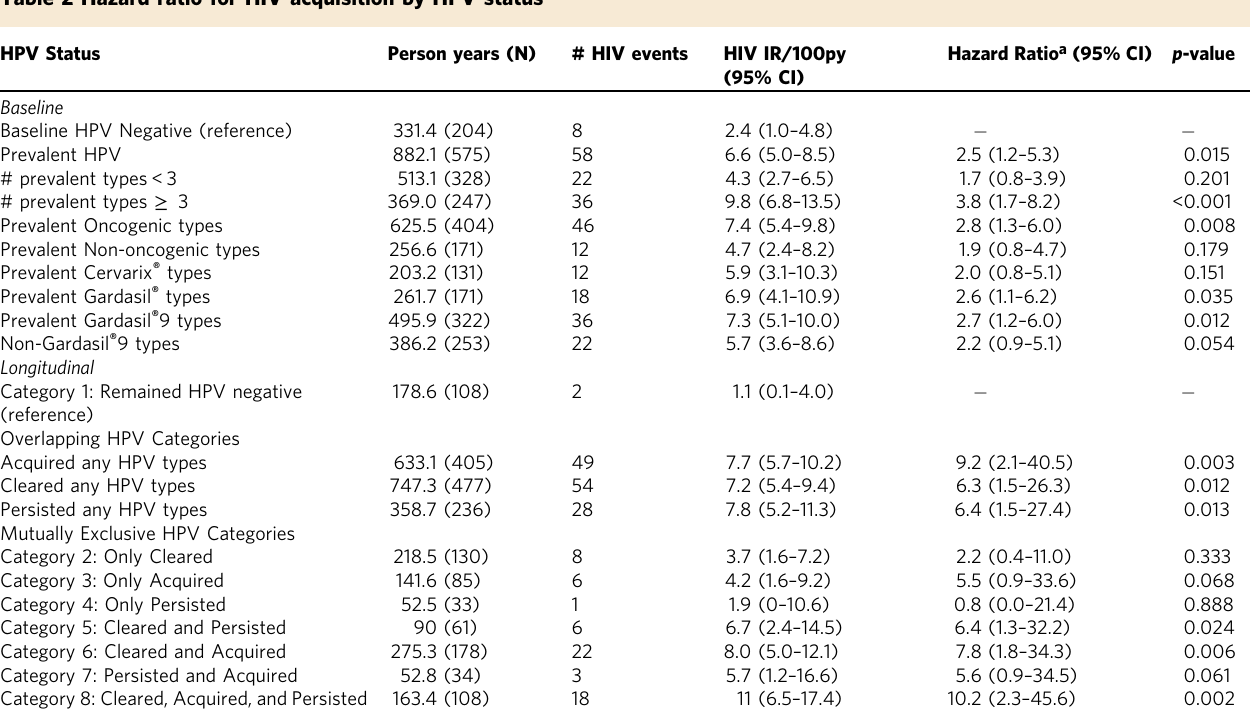
Table 2 Hazard ratio for HIV acquisition by HPV